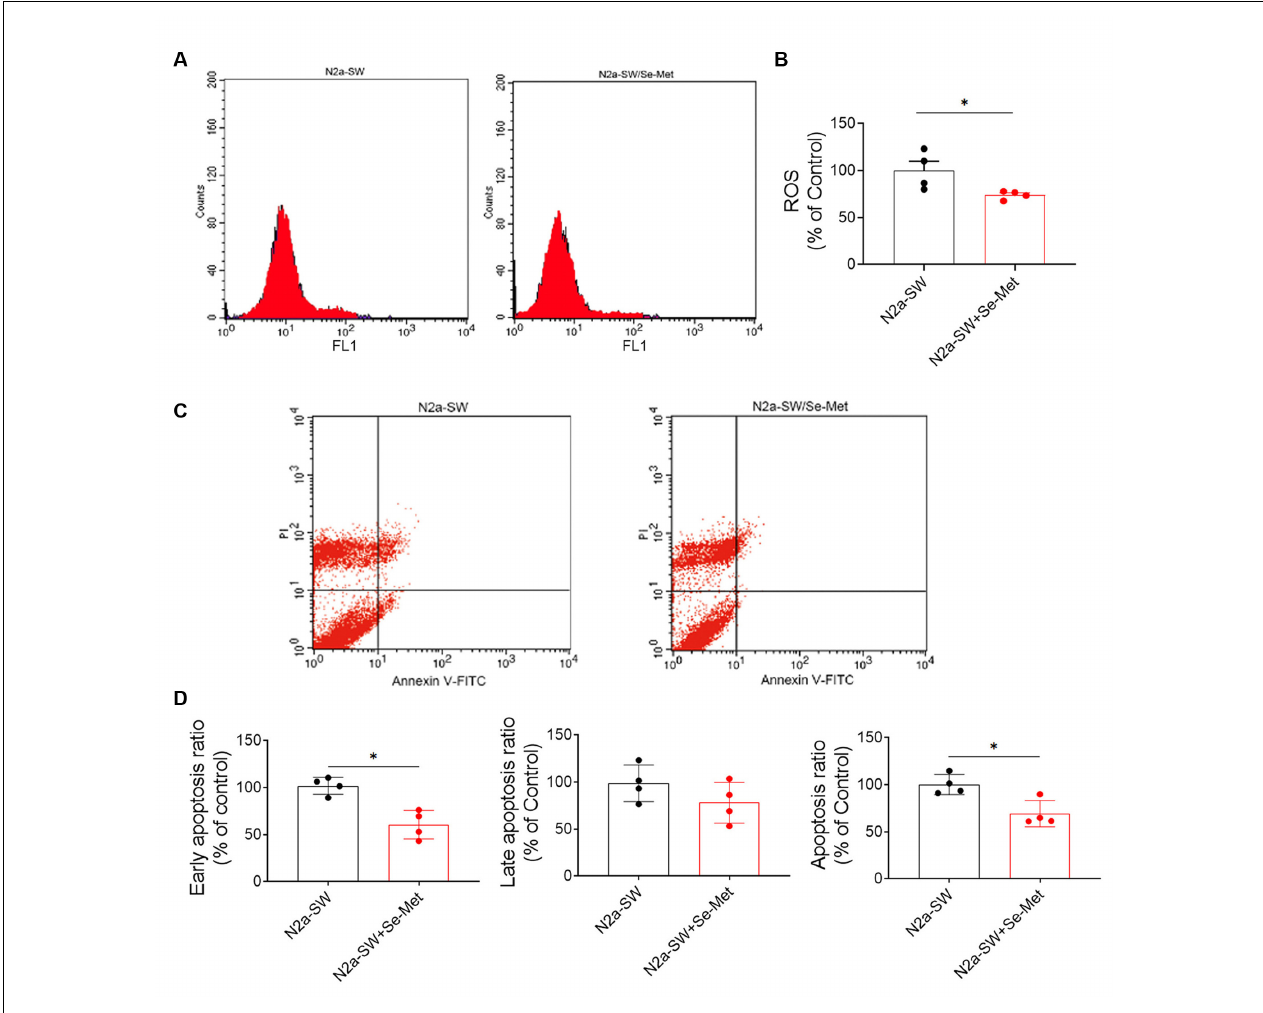
FIGURE 7 | Se-Met attenuated cell damage and reduced apoptosis in the N2A-SW cell model. (A) ROS levels in N2a-SW cells treated with 10 µ M Se-Met. (B) Quantitative analysis of the data in (A) ( ∗ p < 0.05 vs. the control group, n = 4). (C) Apoptosis was detected by flow cytometry. (D) Flow cytometry-mediated quantitative analysis of the early apoptosis, late apoptosis, and total apoptosis rates of the N2a-SW cell line ( ∗ p < 0.05 vs. the control group, n =